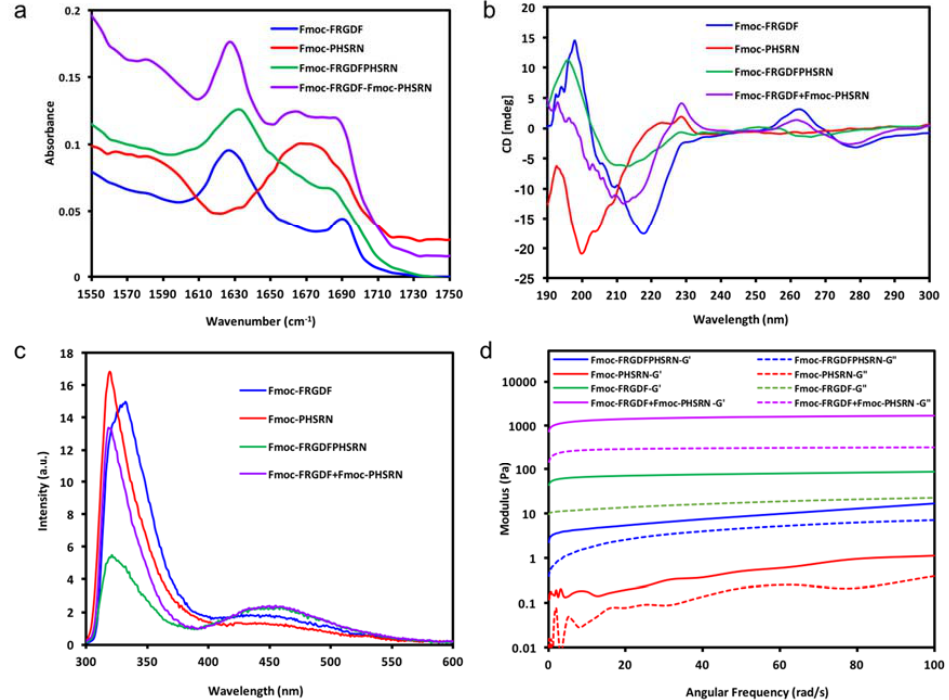
Figure 2. Spectroscopic and rheometer anaylsis for the four peptide hydrogel groups. ( a ) Truncated FT-IR absorption spectra in amide I region; ( b ) CD spectra; ( c ) fluorescence spectra; ( d ) rheometry curves.